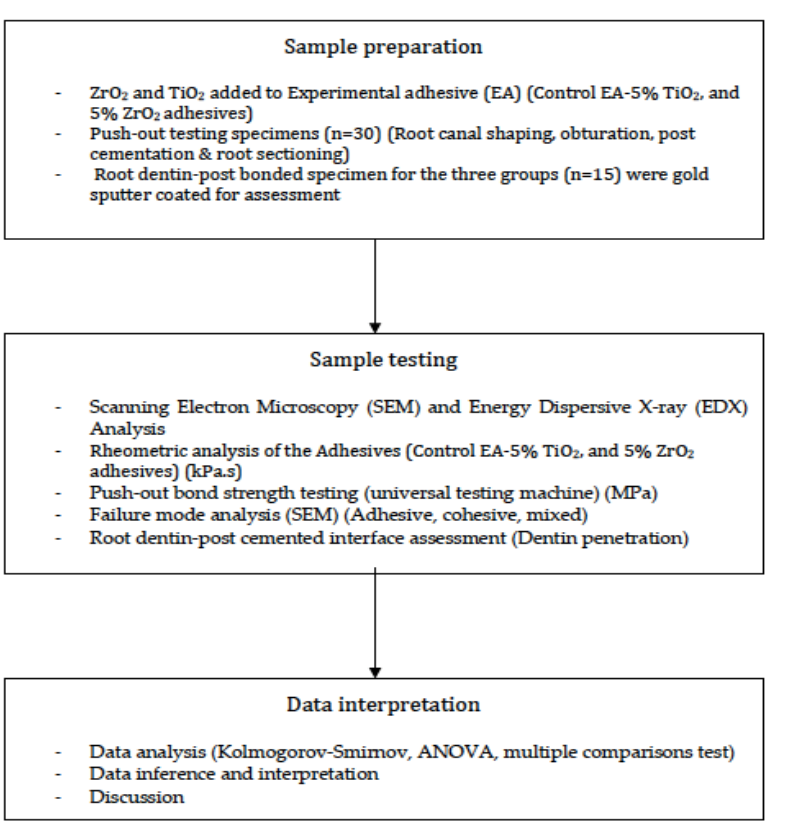
Figure 1. Study methodology.